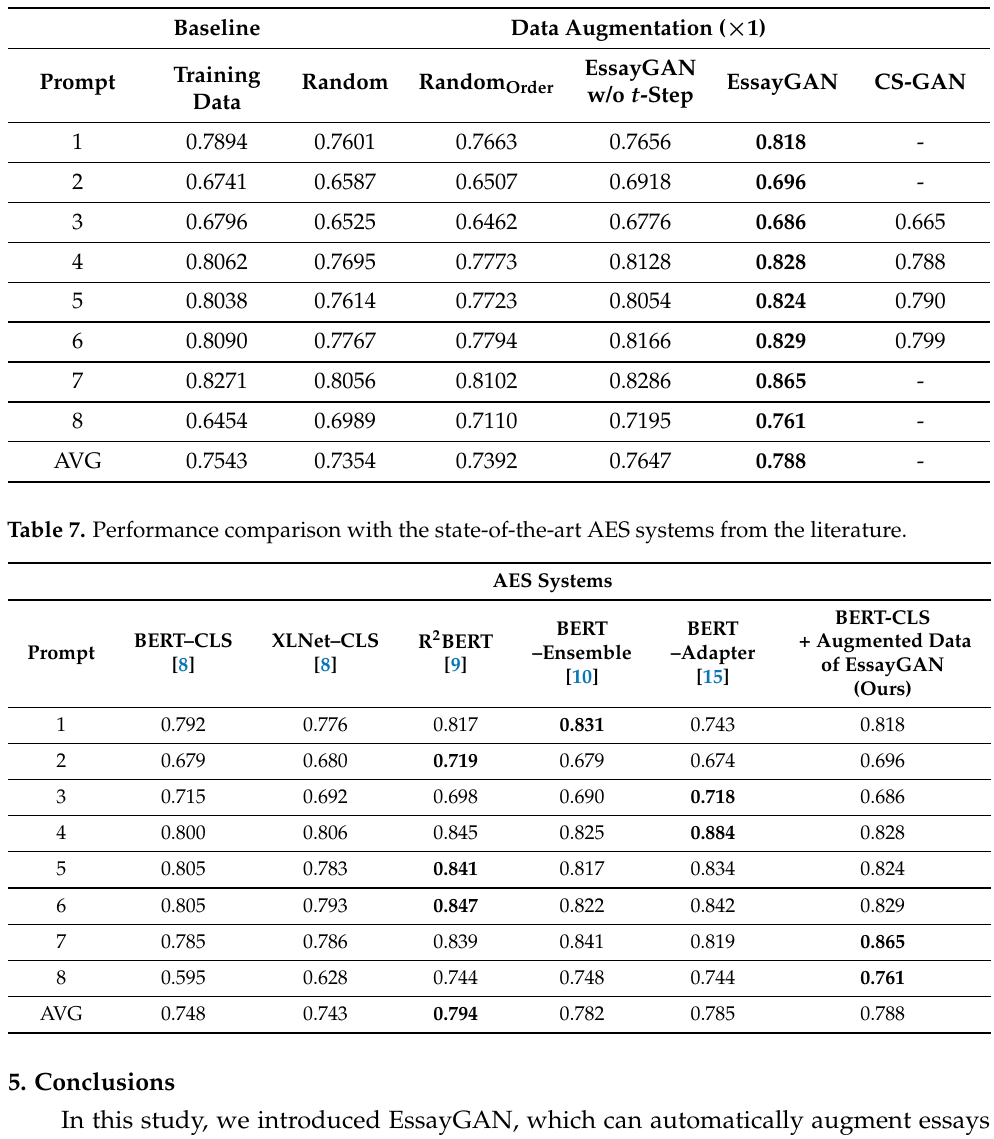
Table 6. QWK correlation comparison between different augmentation techniques.